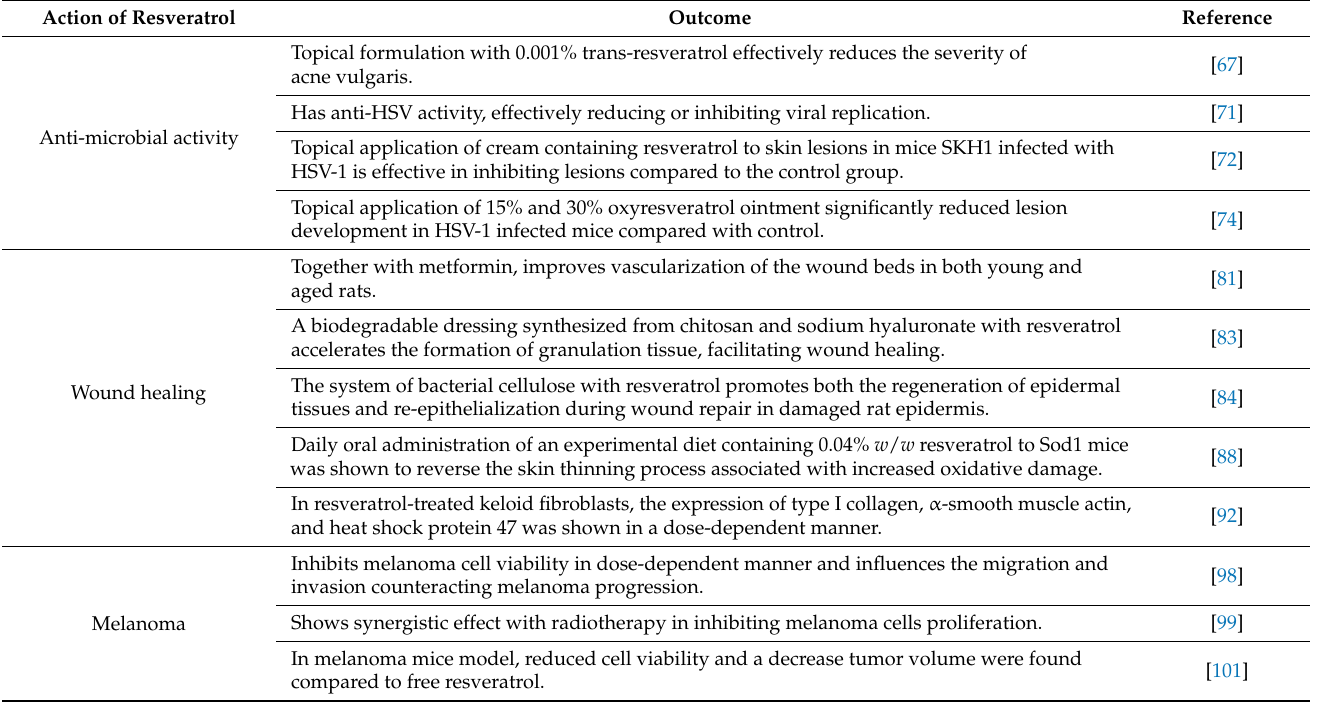
Table 1. A summary of multidirectional action of resveratrol in skin diseases. Action of Resveratrol Outcome Reference